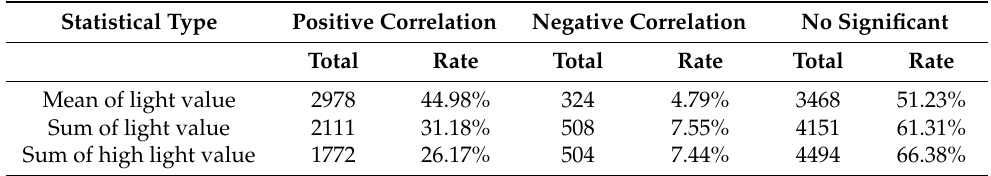
Table 1. Number and rate of townships of various patterns under different statistical methods. Statistical Type Positive Correlation